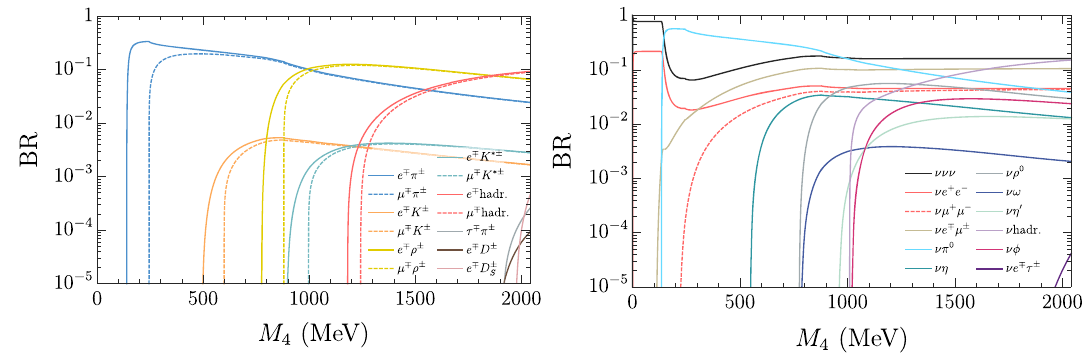
Fig. 1 Branching ratios for the heavy N 4 as a function of its mass, obtained under the assumption of same mixing to all flavors ( | U e 4 | 2 = | U μ | 2 = | U τ | 2 ). Left (right) panels correspond to decays without 4 4